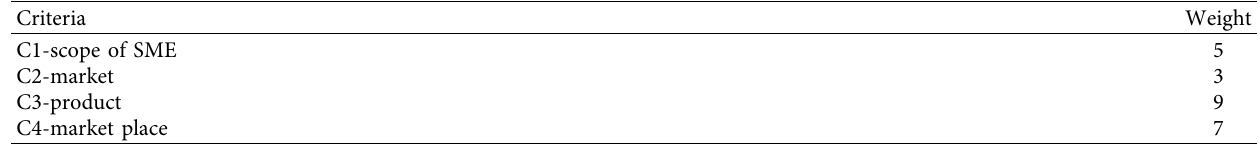
Table 3: Weight of criteria based on expert perspective.